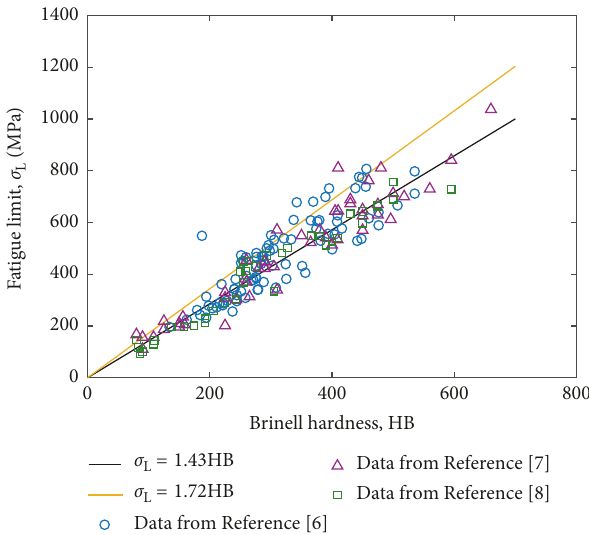
Figure 2: Fatigue limit vs. Brinell